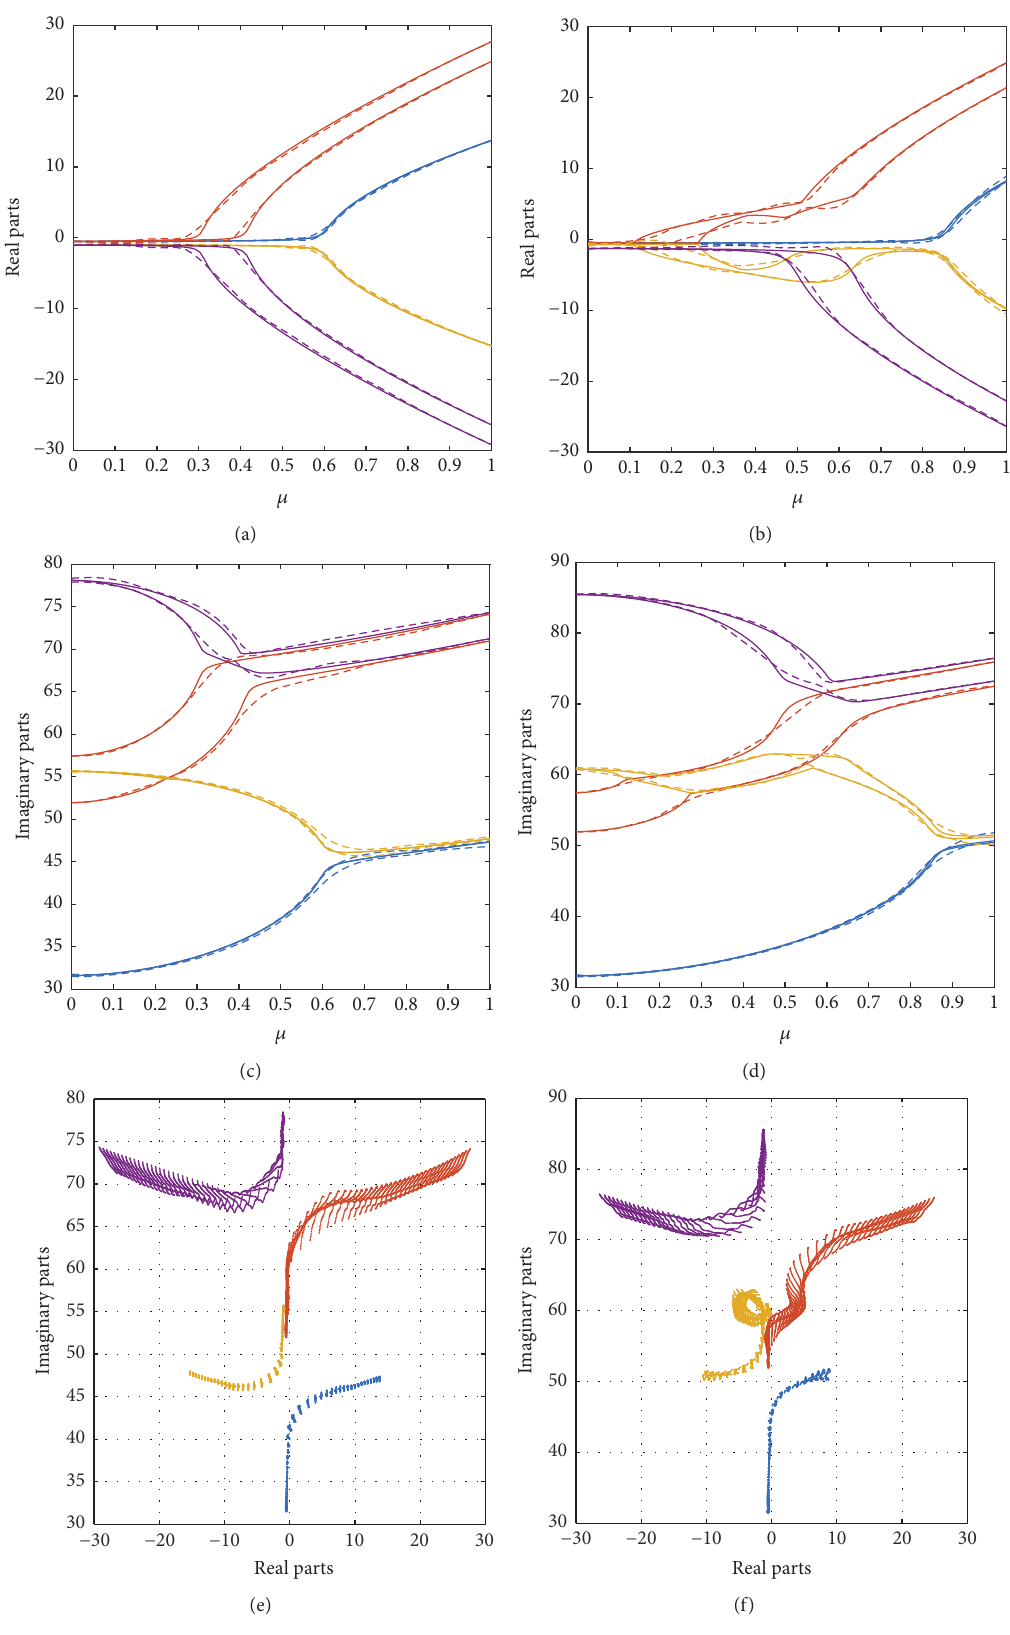
Figure 9: Kriging (--) on two-dimensional parameter space with a 70 points’ LHS as experimental design compared to deterministic results ( − ): real (a, b) and imaginary (c, d) parts of eigenvalues versus 𝜇 for configurations 1 (a, c) and 2 (b, d). Evolution in the complex plan based on kriging metamodel for configurations 1 (e) and 2